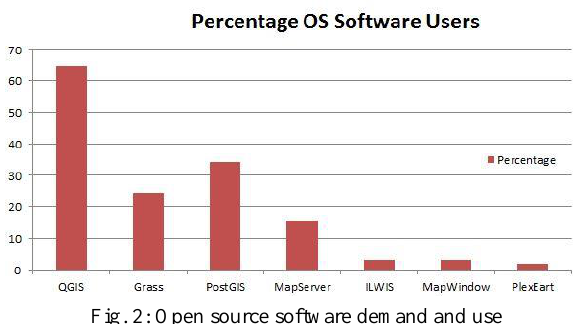
Fig. 2: Open source software demand and use